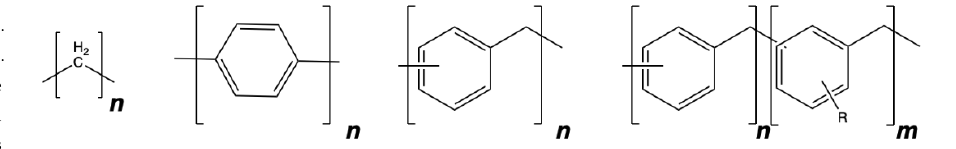
Figure 1. Chemical structure (from left) of polyethylene, poly( p -phenylene), poly(phenylene methylene), and poly(phenylene methylene) containing side chains (R = 4-octyloxy).